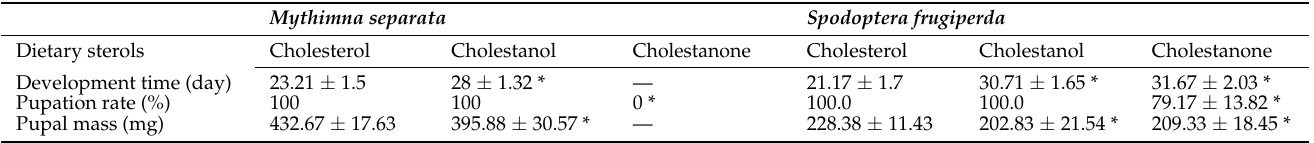
Table 1. Performance of the two caterpillars reared on a diet containing cholesterol, cholestanol, or cholestanone at a concentration of 1 mg/g (dry mass). * in each row indicates significant differences compared to the cholesterol treatment at p < 0.05.